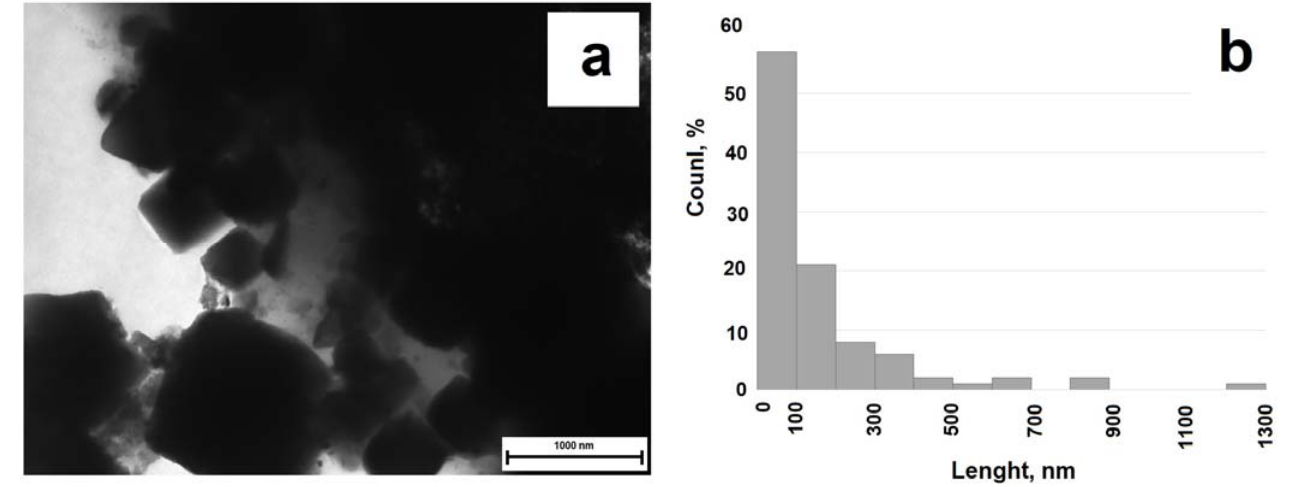
Figure 6. TEM image of the sunflower/CoFe 2 O 4 biochar sample ( a ), particle size distribution ( b ).